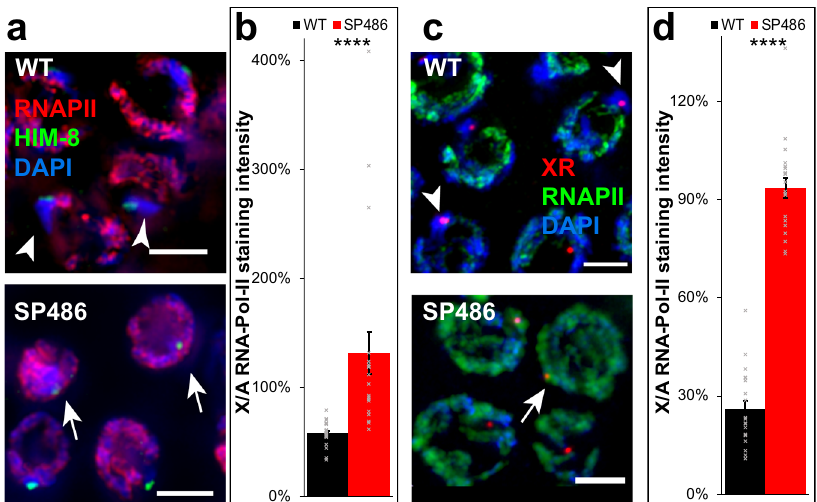
Fig. 6 Reciprocal translocation of X and V chromosomes causes defects in X chromosome meiotic silencing. a Early-mid pachytene nuclei stained with DAPI (blue), anti-RNAPII (red), and anti-HIM-8 (green). b Averages ± SEM of relative RNAPII staining levels in wild-type and YBT68 nuclei on HIM-8- marked body vs. an autosome. c Early-mid pachytene nuclei stained with DAPI (blue), anti-RNAPII (green), and FISH probe to the right side of the X (red). d Averages ± SEM of relative RNAPII staining levels in wild-type and YBT68 nuclei on X-right marked body vs. an autosome. Scale bar = 3 μ M. Arrows indicate chromosomes with no RNAPII staining. Arrowheads indicate chromosomes with signi fi cant RNAPII staining. n = 20 nuclei. **** p < 0.0001, by the two-tailed Mann – Whitney